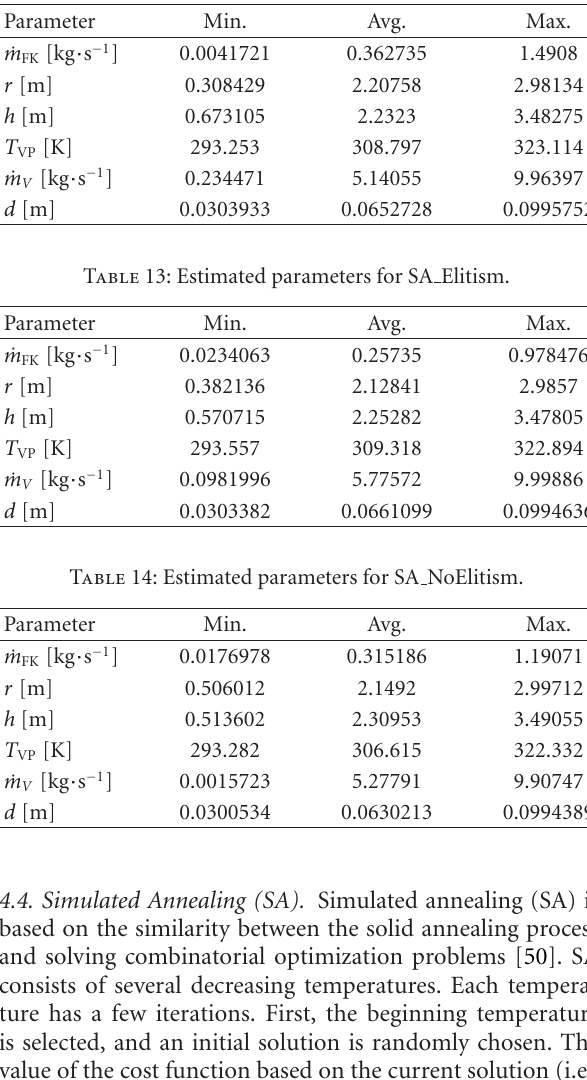
Table 12: Estimated parameters for GA.